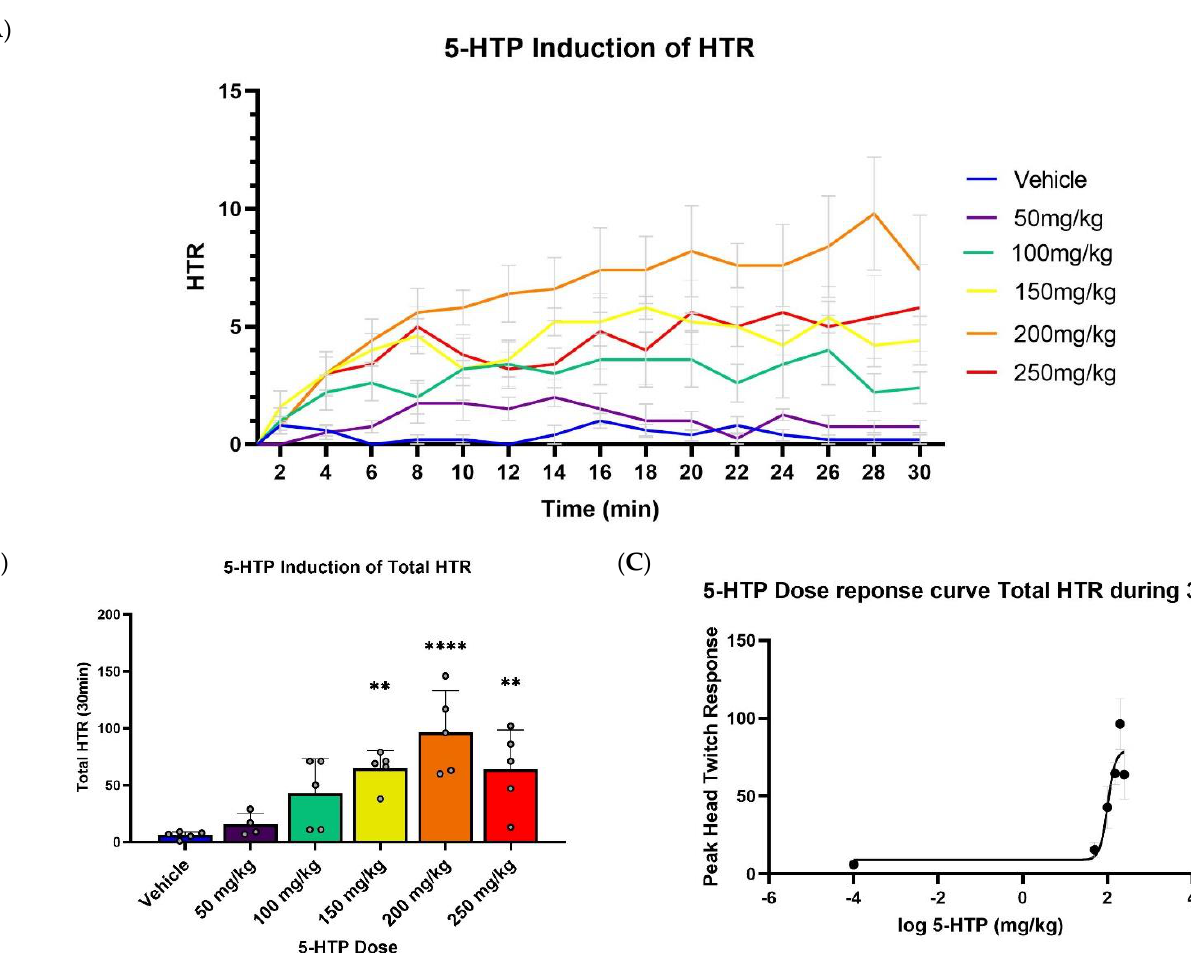
Figure 1. Induction of HTR by 5-HTP, over time ( A ) and total HTR during 30 min ( B ). ( A ) Effect of different 5-HTP concentrations during HTR over the time course of 30 min post-injection ( n = 4 − 5). ( B ) Cumulative HTR during the time of 30 min post injection ( n = 4 − 5). ( C ) Logarithmic dose – response curve compiled from total HTR ( B ). Compared to vehicle, ** p < 0.01, **** p < 0.0001. Error bars represent SEM.